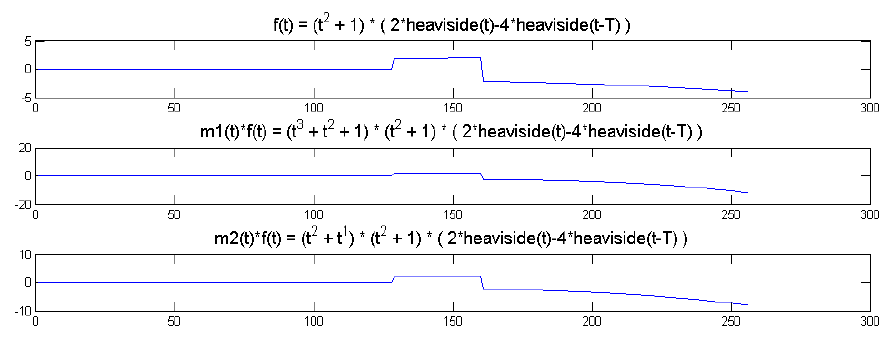
Figure 6. Original and modulated signals. ( Top ) to ( bottom ): f ( t ); m1 ( t ) × f ( t ); m2 ( t ) × f ( t ).